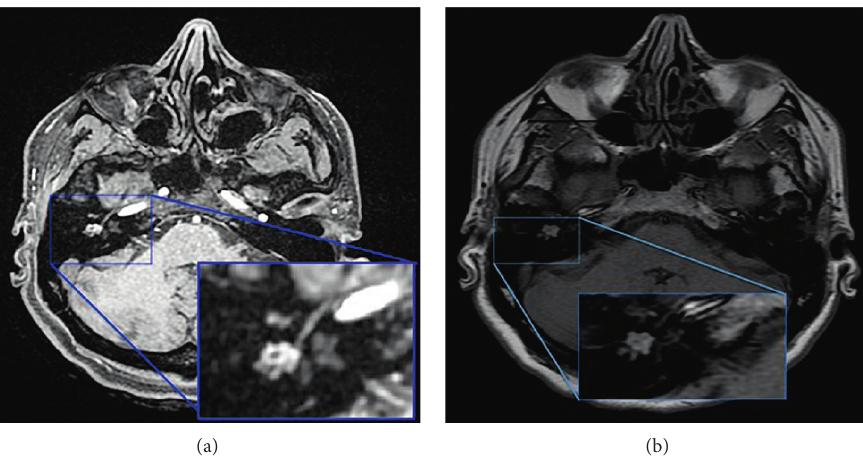
Figure 2: Axial magnetic resonance imaging (MRI) scans of the middle ear. (a) T1 fat-saturated MRI revealed tissue in the middle ear. (b) T1 diffusion-weighted imaging did not show a restriction of diffusion in the tissue, as is typical of cholesteatoma.